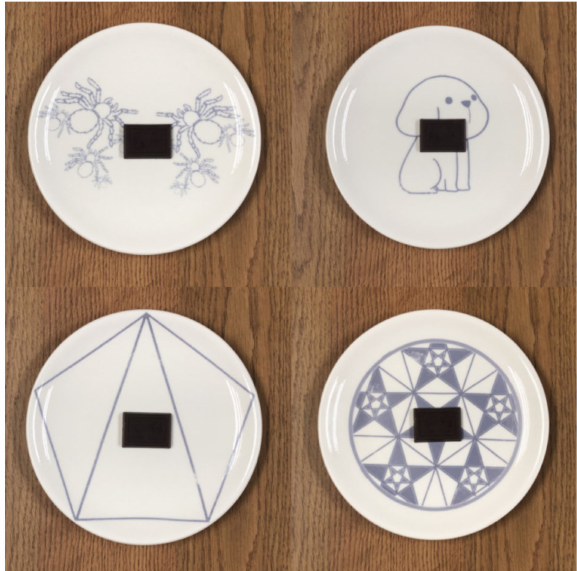
Figure 3. Example of expressive aesthetic pattern plates ( top ) and classical aesthetic pattern plates ( bottom ) combined with the chocolate. The plates on the right side were both rated as having a high beauty level and those on the left were rated as having a low beauty